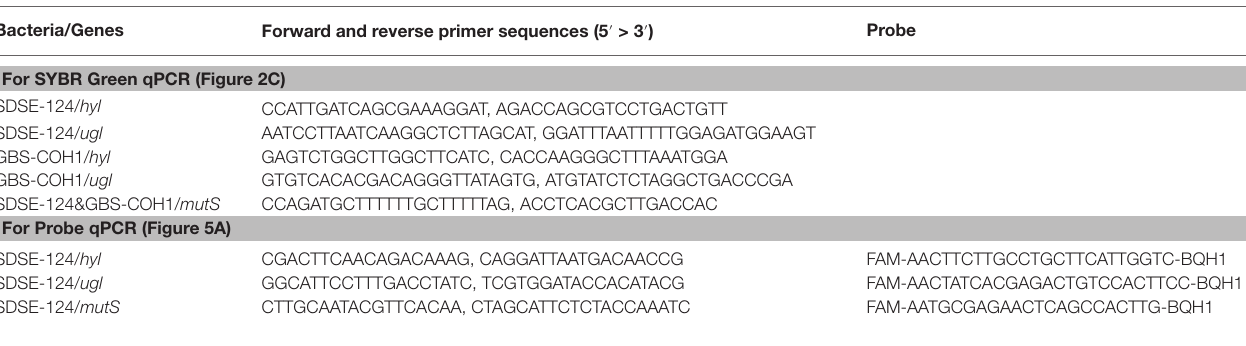
TABLE 1 | Primers and probes used in this